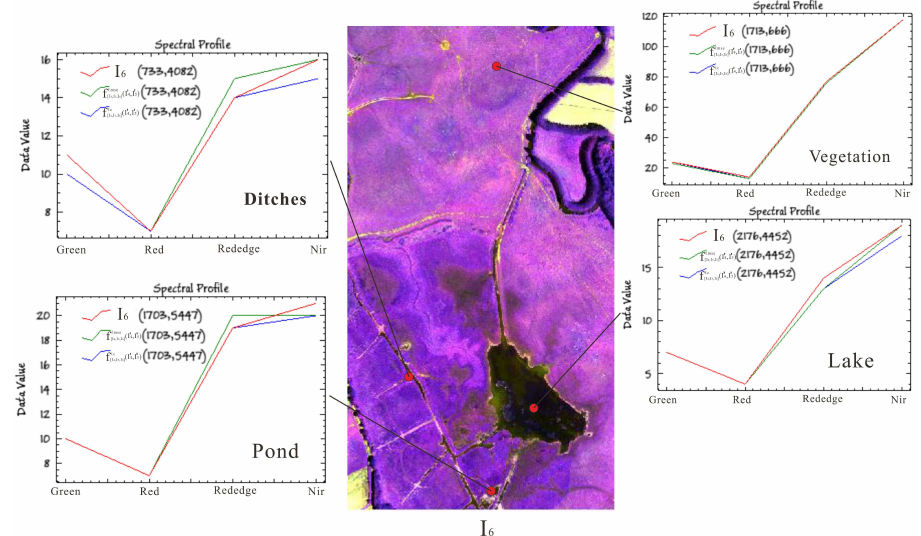
Figure 11. Spectral curves between scene interpolated result and reference scene image using different loss functions at different coordinates in June